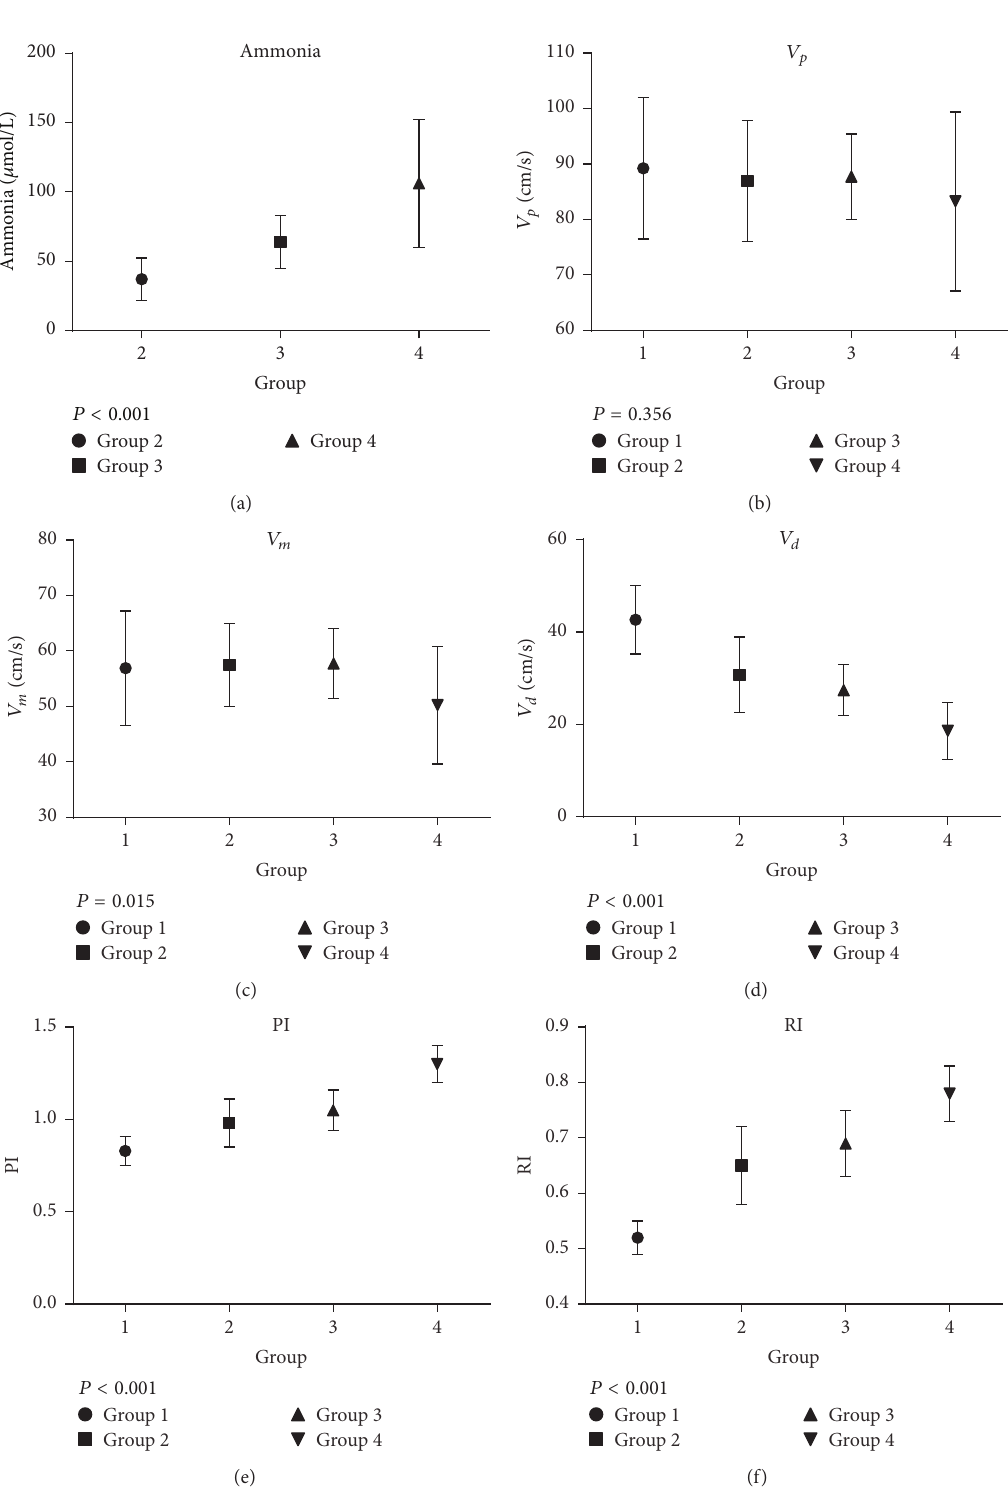
Figure 1: Comparison of ammonia and TCD among groups 1, 2, 3, and 4 before treatment . It includes the subfigures (a, b, c, d, e, and f). Subfigure (a) is comparison of ammonia among groups 2, 3, and 4. Subfigure (b) is comparison of 𝑉 𝑝 among groups 1, 2, 3, and 4. Subfigure (c) is comparison of 𝑉 𝑚 among groups 1, 2, 3, and 4. Subfigure (d) is comparison of 𝑉 𝑑 among groups 1, 2, 3, and 4. Subfigure (e) is comparison of PI among groups 1, 2, 3, and 4. Subfigure (f) is comparison of RI among groups 1, 2, 3, and 4. Group 1 is healthy controls group, group 2 is cirrhosis without HE group, group 3 is cirrhosis with MHE group, and group 4 is cirrhosis with OHE group. The data were compared using ANOVA and presented as mean ± SD. 𝑃 < 0.05 means significant differences in an index among